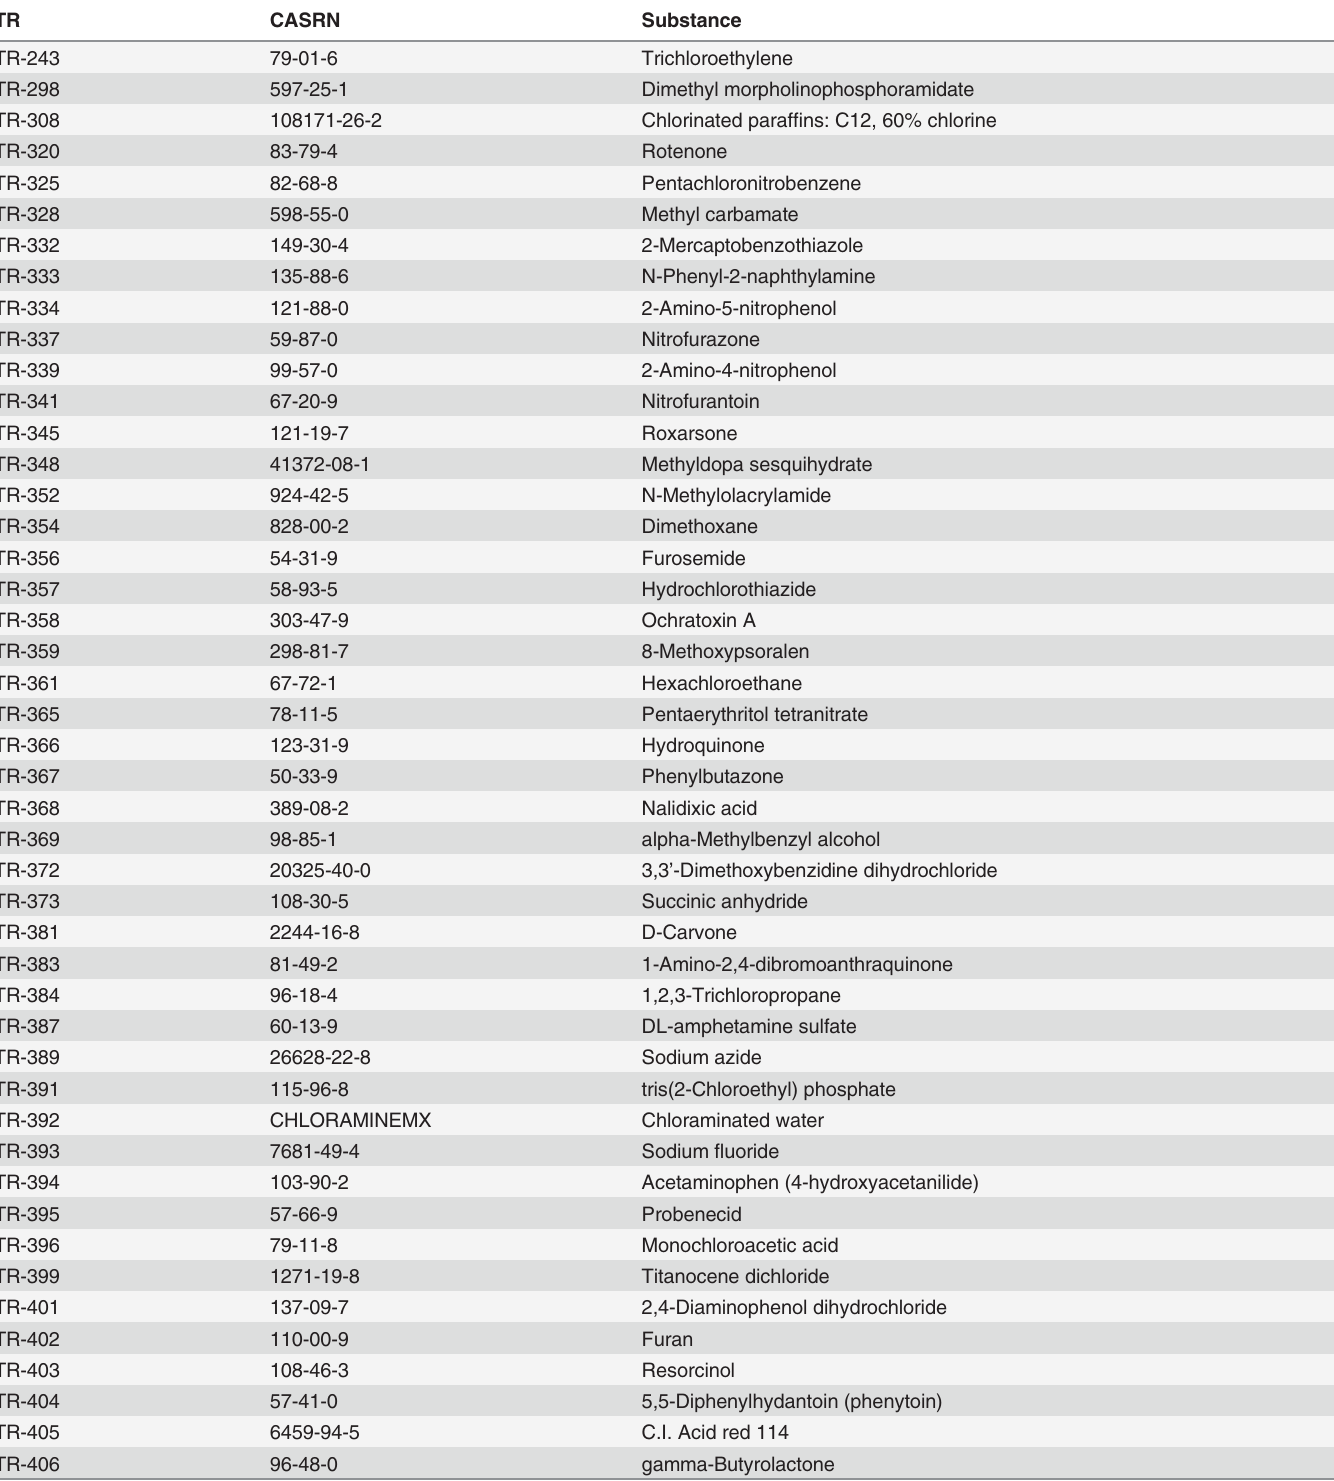
Table 1. List of 2Y-CSs on single substances that were included in the